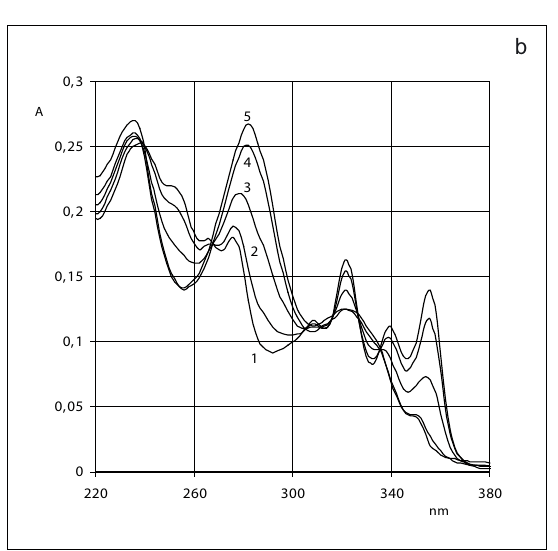
Table 1. Molar absorptivities ε different experimental conditions